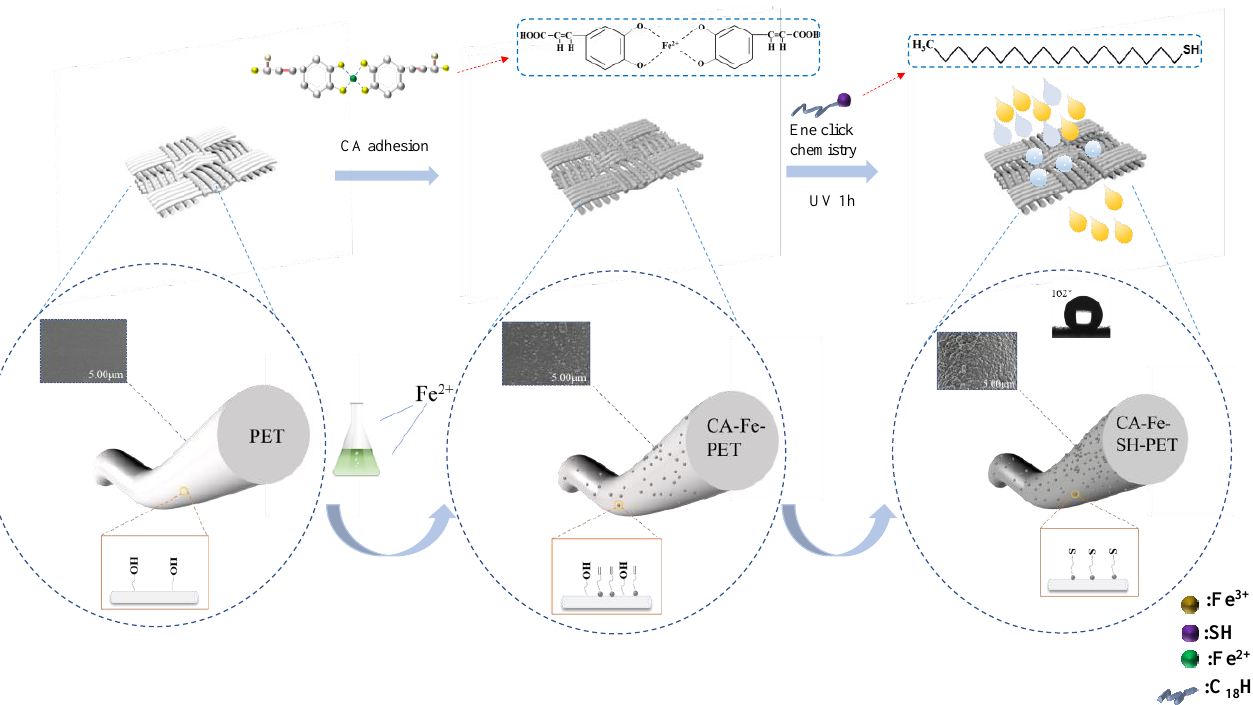
Figure 2. Preparation process for superhydrophobic polyester fabric.